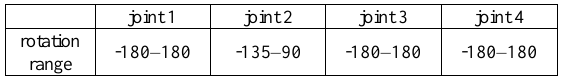
Table 1. Rotational range of each joint